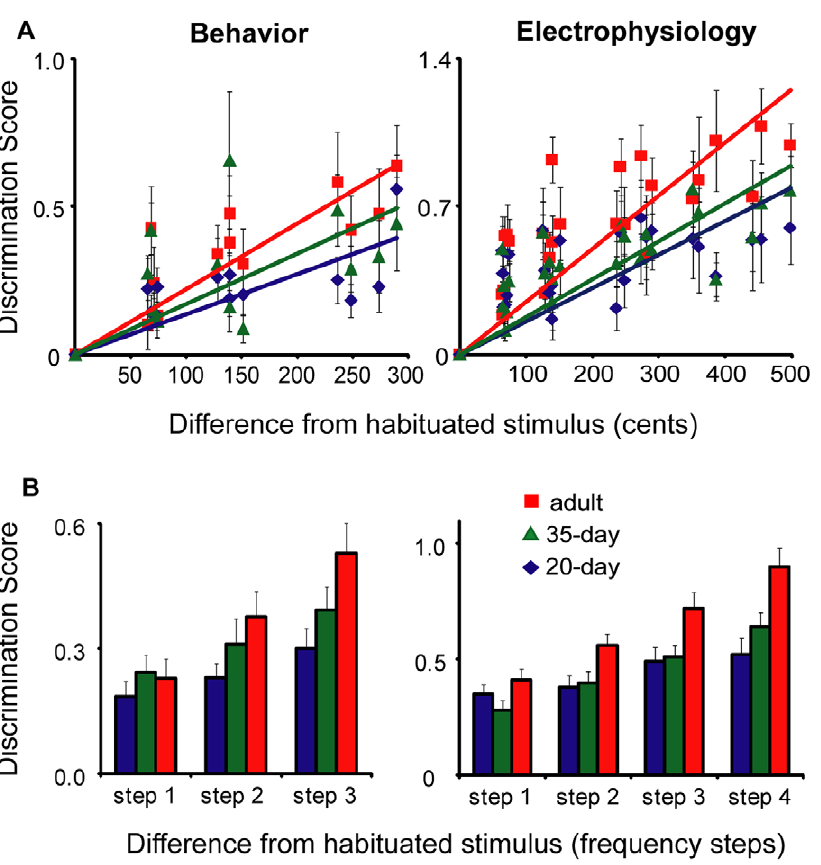
Figure 3. Steepness of discrimination gradients as a function of age. (A) Data from Fig. 2 plotted as psychometric functions showing discrimination score versus cents difference from habituated stimulus (both higher and lower). Trendlines for each graph have y-intercept set to 0 for ease of comparison (see Methods). (B) Discrimination scores for each age group at increasing steps of frequency away from the habituated stimulus (see Results). For both A and B, behavioral data are plotted in the left panels, and neural data from NCM are plotted in the right panels. All values are mean 6 SEM.